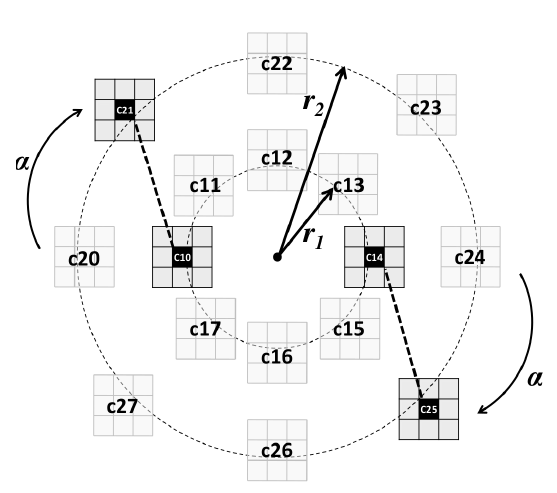
Figure 13. The Four-Patch LBP code with α = 1, w = 3 and S = 8